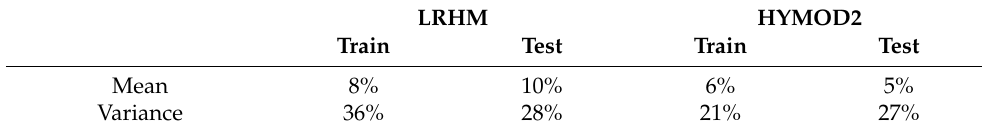
Table 6. Percentage reduction of the mean value and variance of the ML approximator over the hydrological models LRHM and HYMOD2.